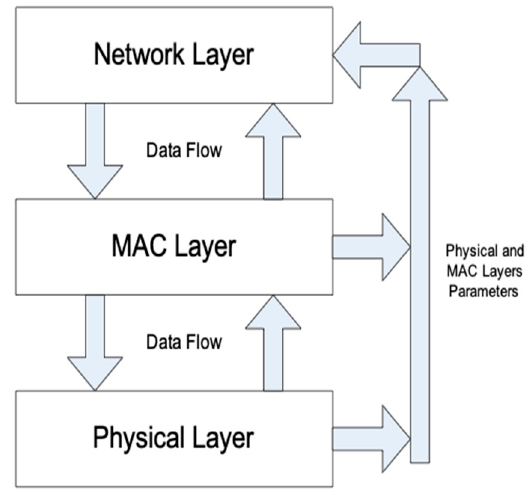
Figure 5. The Cross Layer Approach to Routing.